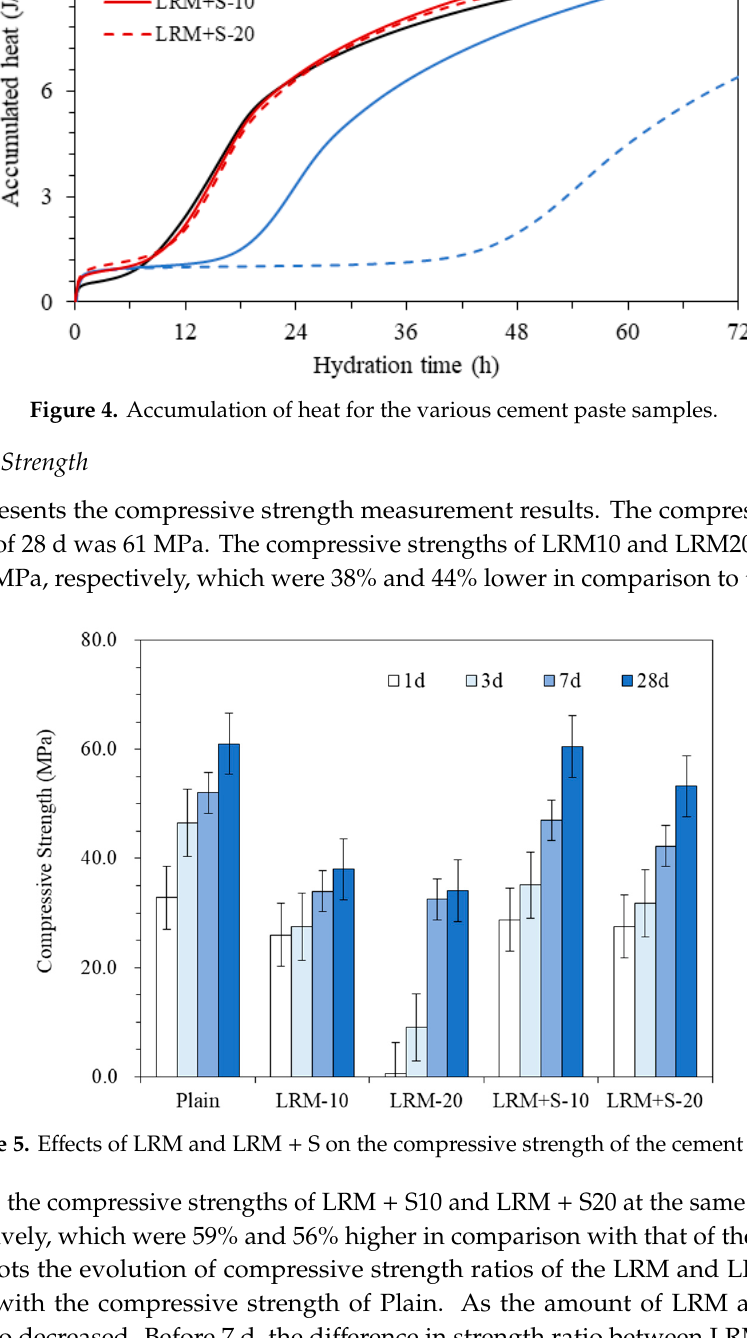
Figure 6. Effects of LRM and LRM + S on the compressive strength ratio of the cement paste. 3.3. Microstructure Figure 7 presents the XRD results obtained for different ages. Portlandite is the main hydration product of cement, and calcium silicate is the unhydrated substance [23]. As shown in Figure 7a, portlandite, the main hydration product, was observed at 2 θ = 18.1°, 34.1°, and 47.2° at 1 h for Plain. In general, portlandite is continuously observed in cement paste after watering. However, in the case of the cement paste with added LRM and LRM + S, the main peak of portlandite was not observed at 2 θ = 18.1°. This appears to be due to the presence of Na-based compounds in red mud; this agrees with the results of a previous study wherein portlandite was not initially observed when Na-based compounds were added to cement paste [24]. In addition, owing to the first peak appearing 1 h earlier in the heat of hydration result (Figure 3a), ettringite was observed in 1 h even in the XRD result. Figure 7b shows that the cement paste with LRM did not exhibit the Ca(OH) 2 peak at 2 θ = 18° and 1 d, but the peak was observed at 2 θ = 18° when LRM + S was added. As LRM + S was prepared